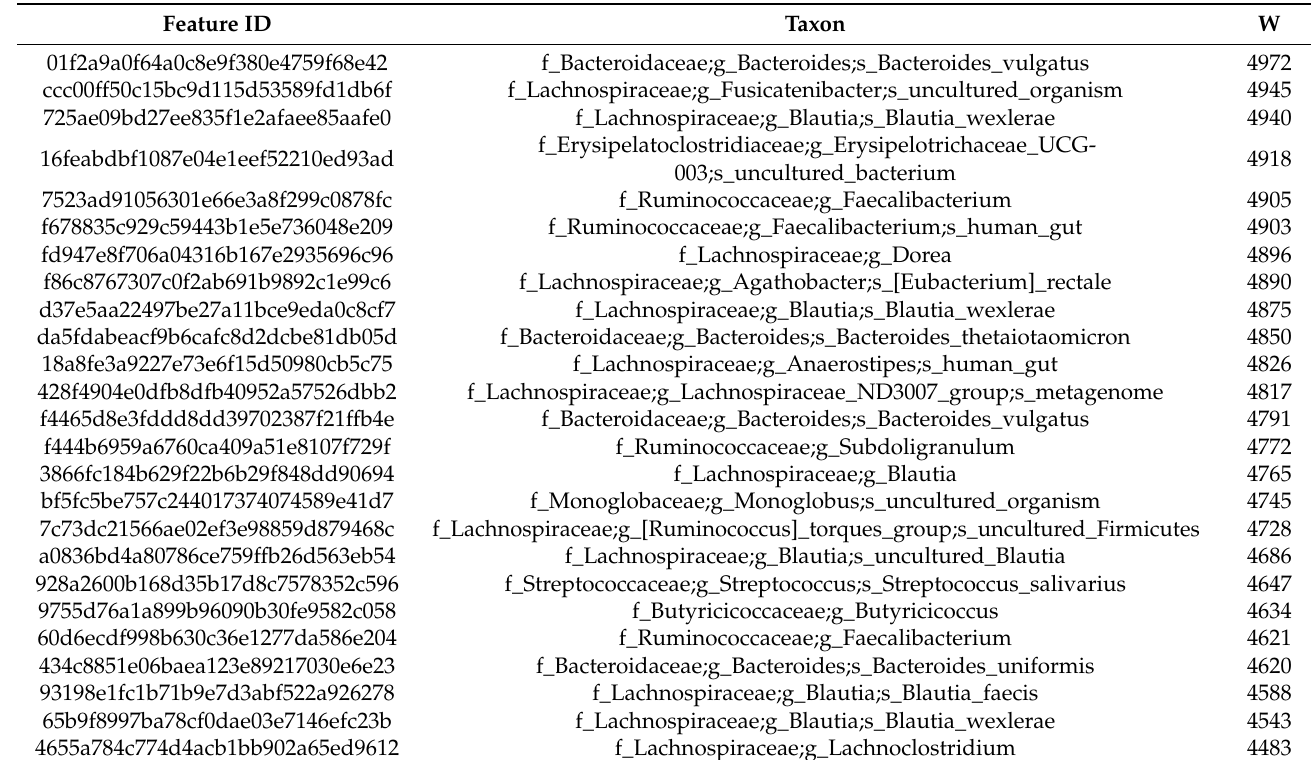
Table 2. Differentially abundant ASV (taxonomical unit assigned by q2-feature-classifier) identified by